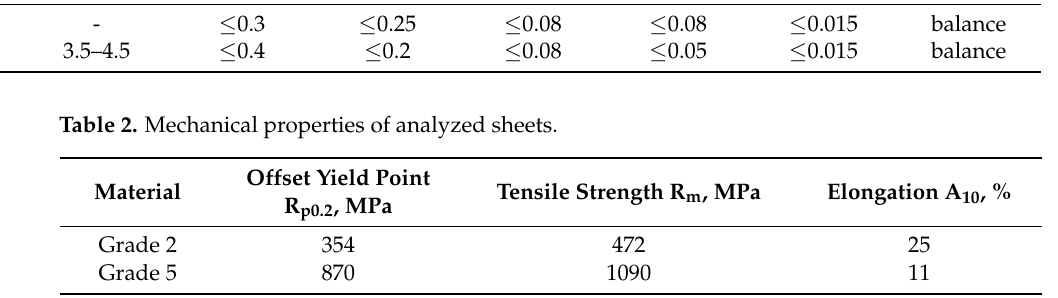
Table 2. Mechanical properties of analyzed sheets.